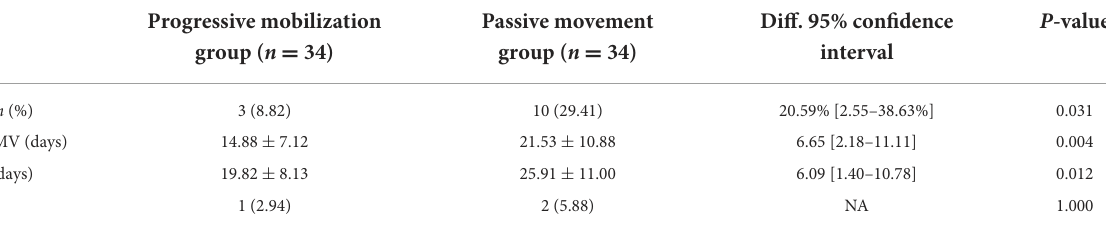
TABLE 2 Comparison of validity between the two groups.